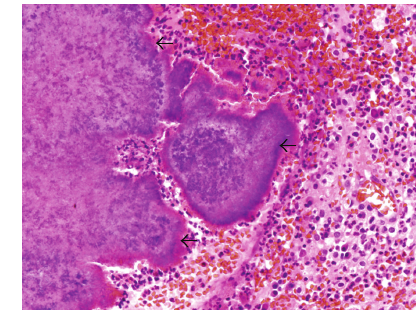
Figure 1: CT features of fishbone-associated actinomycosis of the right anterior cervical space.